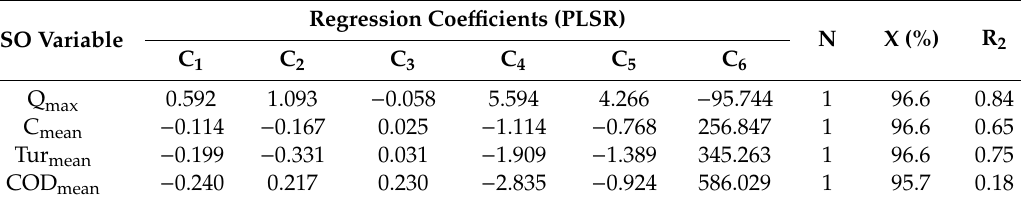
Table A6. Regression coe ffi cients for the prediction equations of the CSO variables as a function of the rainfall parameters for the Coliseo CSO. R 2 is the coe ffi cient of determination of the PLSR.-N is the number of components used to build the PLSR model and X is the percentage of variability explained by the model.